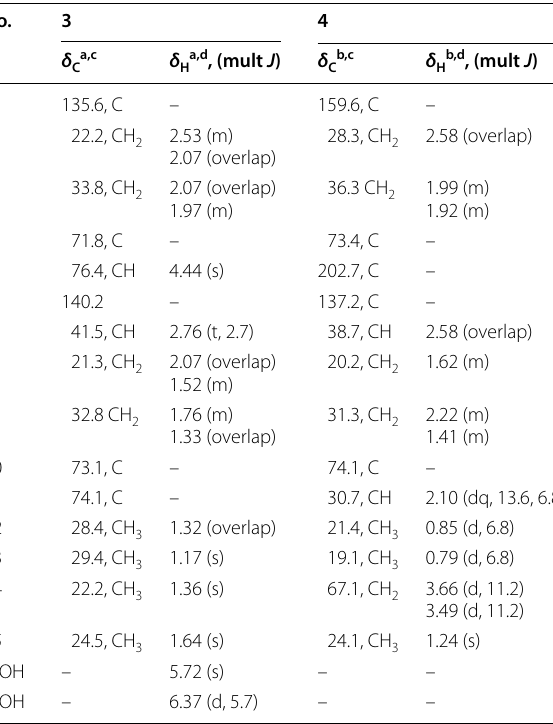
Table 2 1 H and 13 C NMR spectroscopic data for compounds 3 and 4 ( δ in ppm, J in